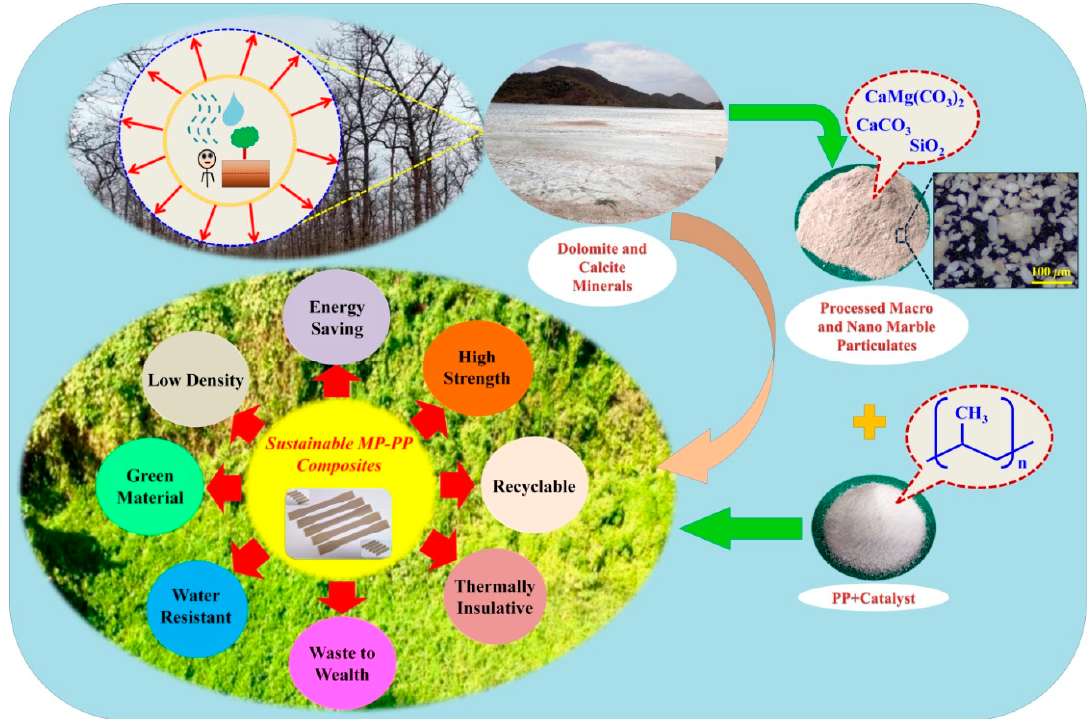
Figure 1. The schematic diagram for the fabrication of the composites.